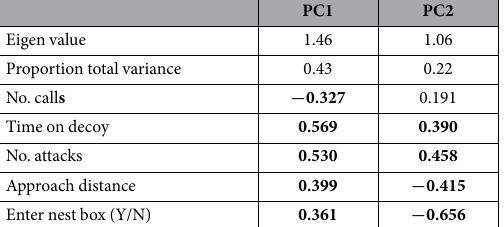
Table 1. PCA loadings for aggression parameters scored during simulated territorial intrusion in female great tits (N = 98). Approach distance was multiplied by − 1 prior to analysis. Parameters contributing importantly to a component are highlighted in bold.